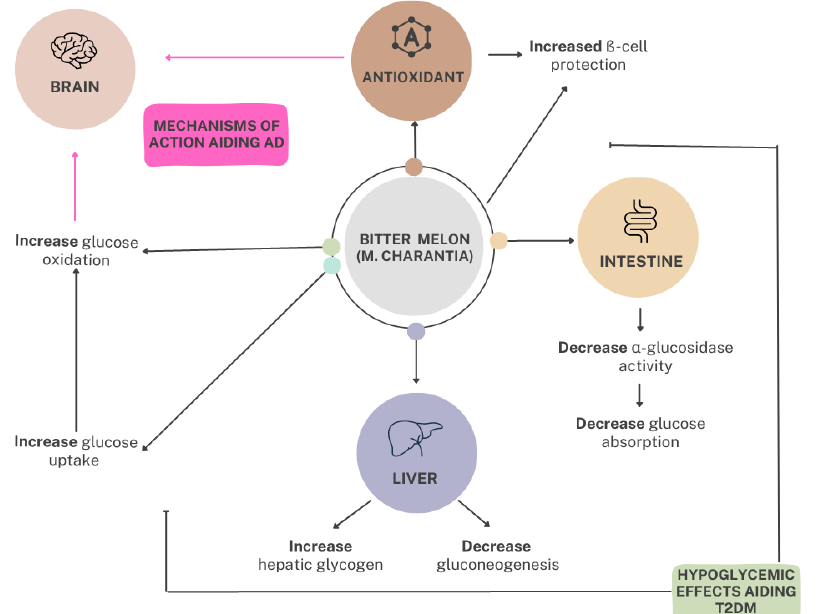
Figure 2. The mechanisms of action of bitter melon in the reduction of blood glucose in relation to T2DM and AD. M. charantia maintains hypoglycemic effects through antioxidant effects promoting ß-cell protection and the decrease in glucose absorption from the intestines and glucose production from the liver by increasing hepatic glycogen and decreasing gluconeogenesis. Thus, from the consumption of bitter melon, glucose uptake and oxidation within the brain are impacted, directly affecting the brain’s energy source. The overall effect of these mechanisms influences the prevention and treatment of T2DM and AD. T2DM, type 2 diabetes mellitus; AD, Alzheimer’s